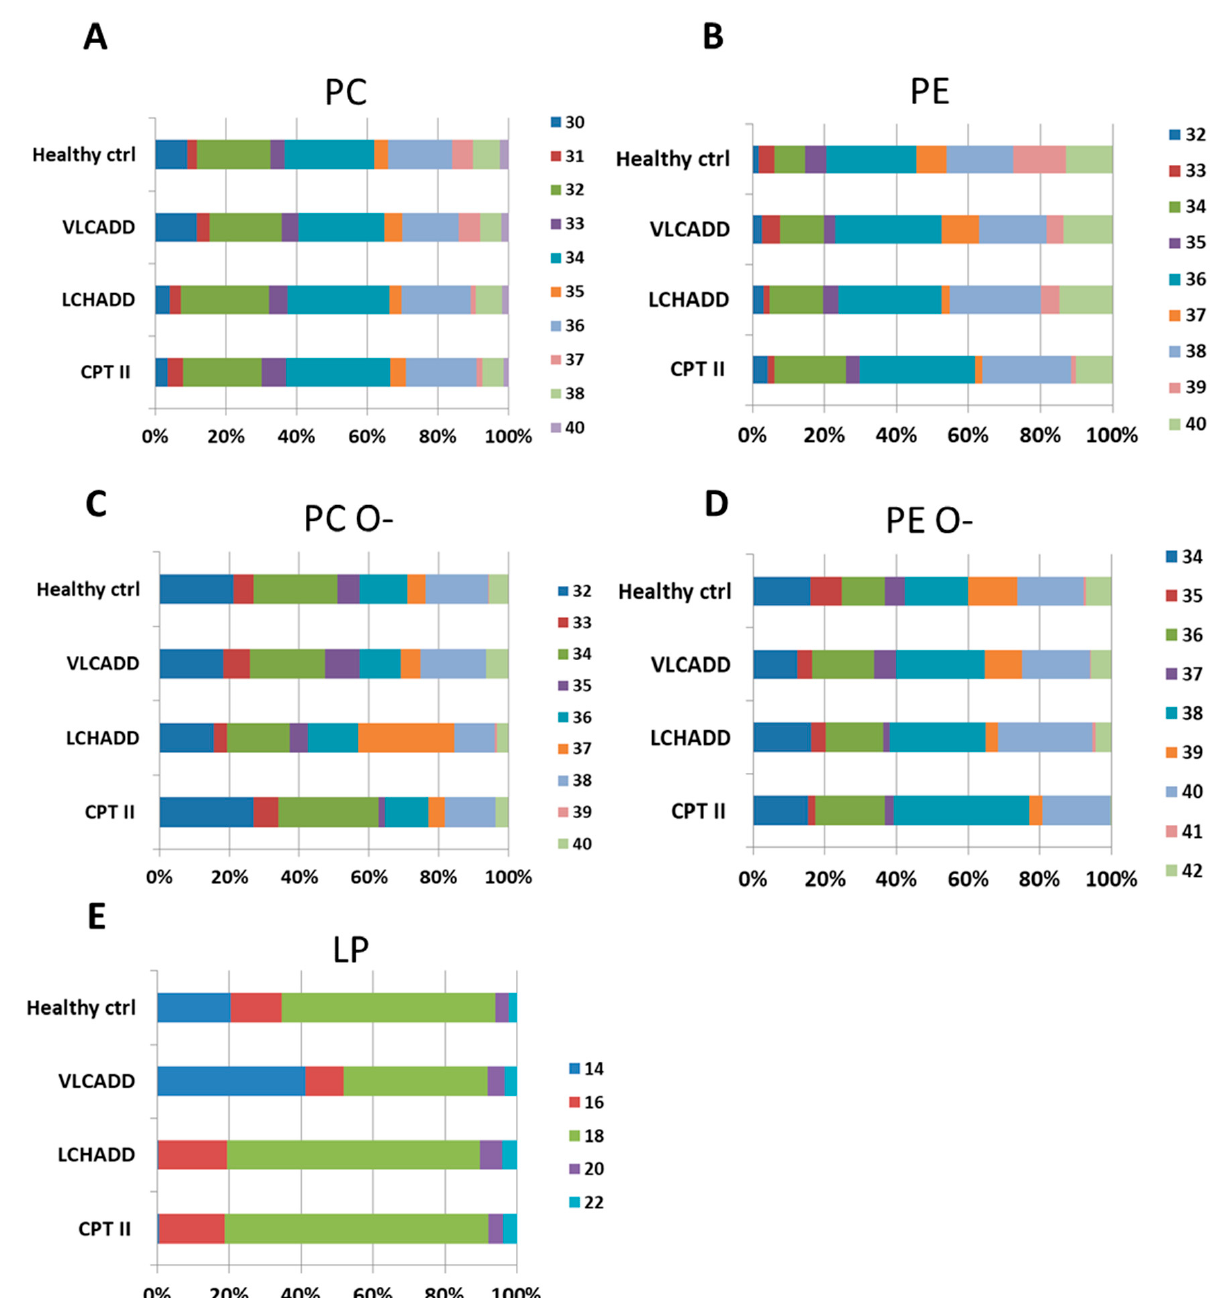
Figure 2. Change of total fatty acid chain length in phosphatidylcholine ( A ), phosphatidylethanolamine ( B ), their corre- sponding plasmalogens PC O-: Phosphatidylcholine (-ether) ( C ) and PC O-: Phosphatidylethanolamine (-ether)-( D ) and lysophospholipids ( E ). Concentrations of the measured fatty acid chain length are represented as percentages. Mol % sample: indicates the moles of the lipid species extracted from one sample calculated as percentage of the total amount of lipid extract.